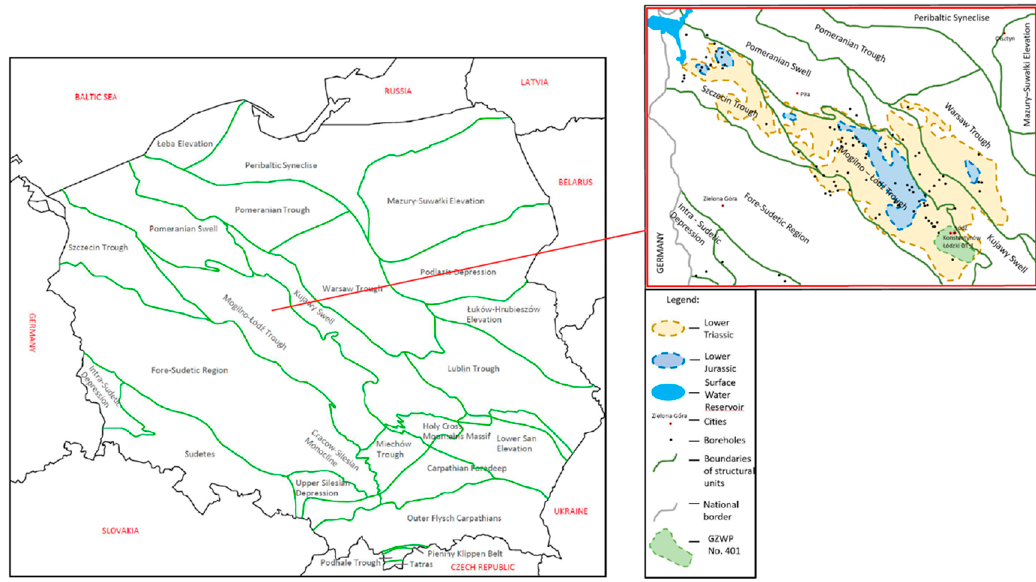
Figure 2. Map of borehole locations with a depth of over 2500 meters below ground level, mainly for the Polish lowlands, based on [21].